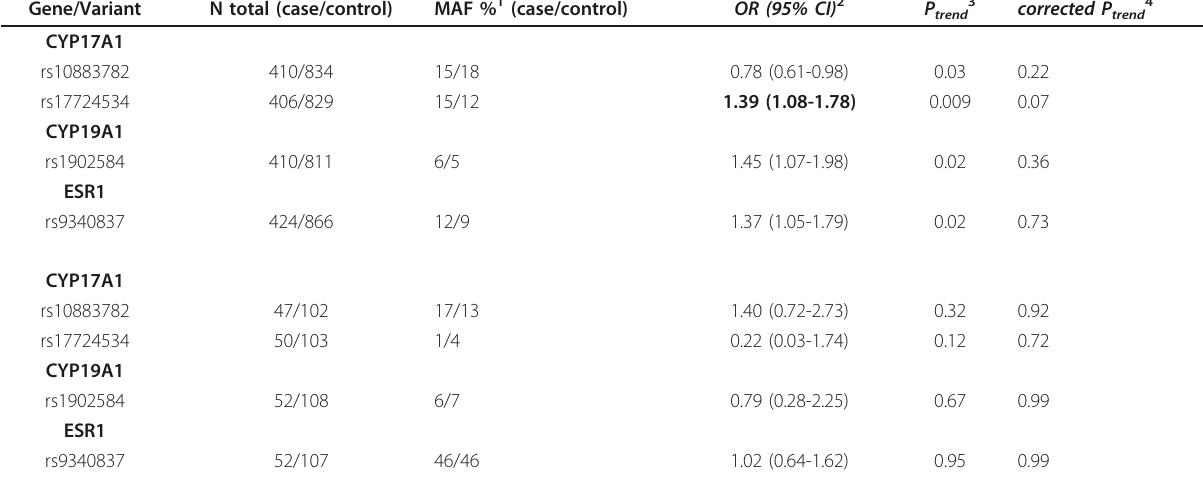
Table 3 Variation in sex-steroid hormone synthesizing enzymes and receptor in relation to colorectal cancer risk in the Women ’ s Health Initiative Observational